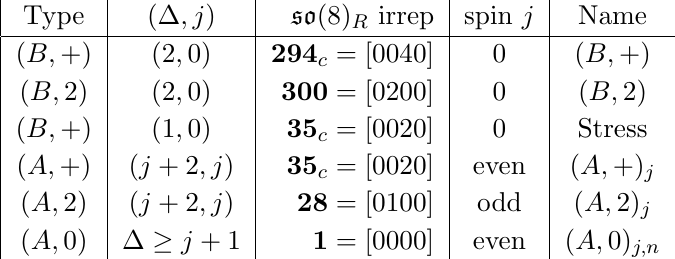
Table 2 . The possible superconformal multiplets in the O Stress (cid:2)O Stress OPE. The so (3 ; 2) (cid:8) so (8) R quantum numbers are those of the superconformal primary in each